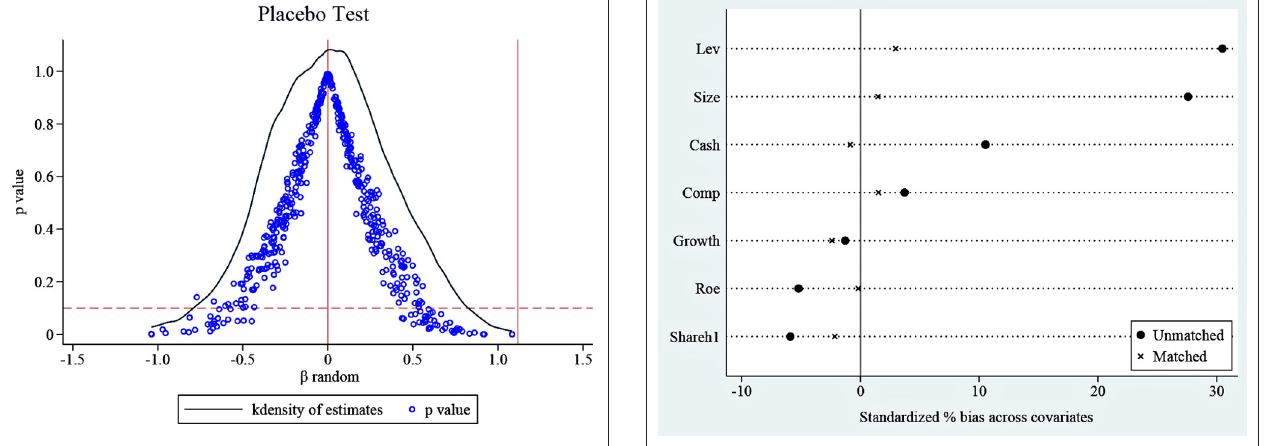
FIGURE 4 | Standardized deviation before and after